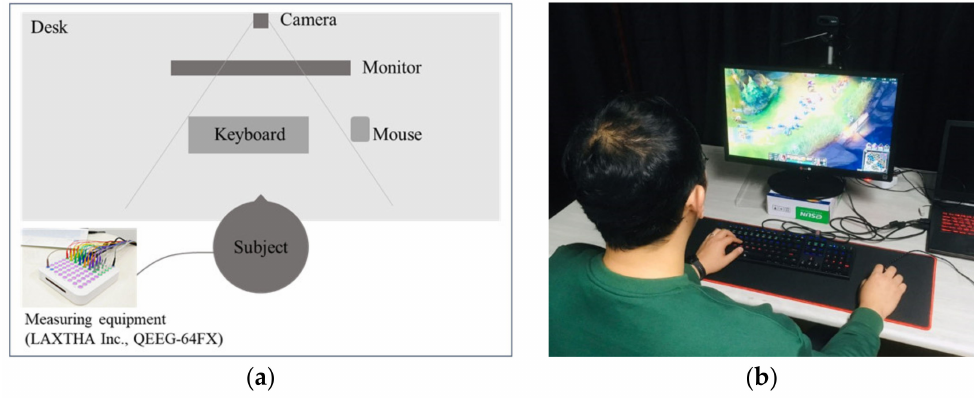
Figure 1. ECG measurement equipment. ( a ) Top view of experimental set-up, ( b ) The experimental